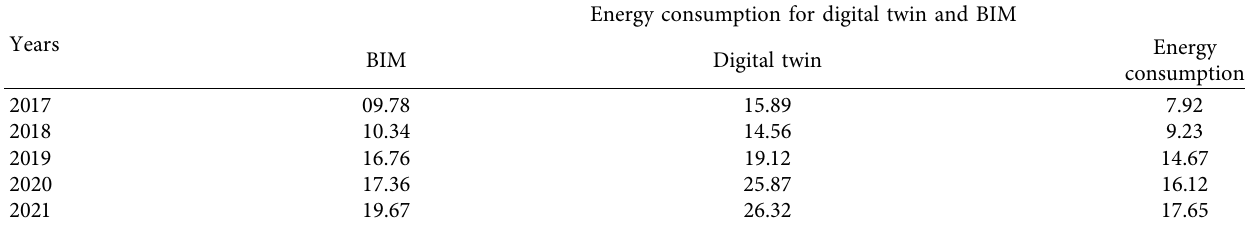
Table 4: Result analysis for energy consumption for digital twin and BIM using AI technology.